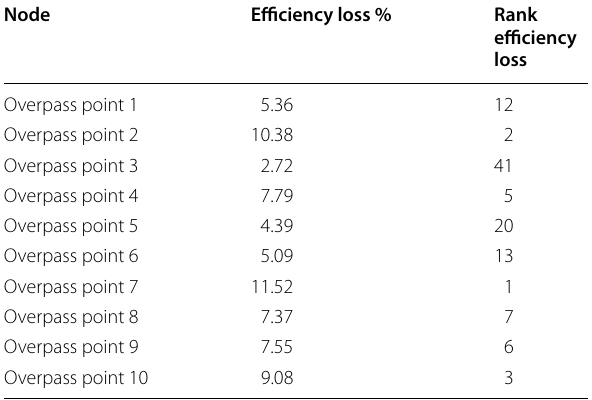
Table 2 Results from the vulnerability analysis—efficiency